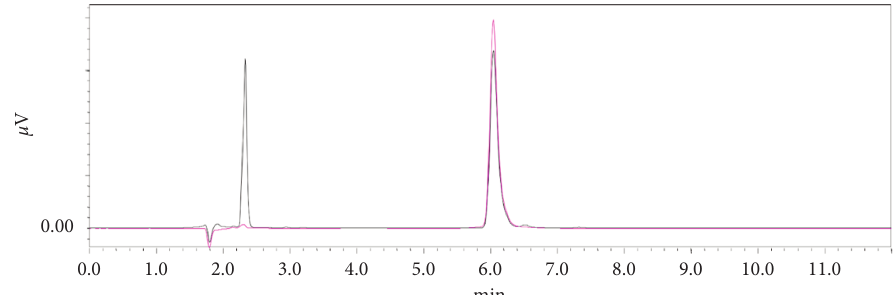
Figure 3: Typical chromatogram for the degraded levamisole standard with heating ( : intact drug; : degraded